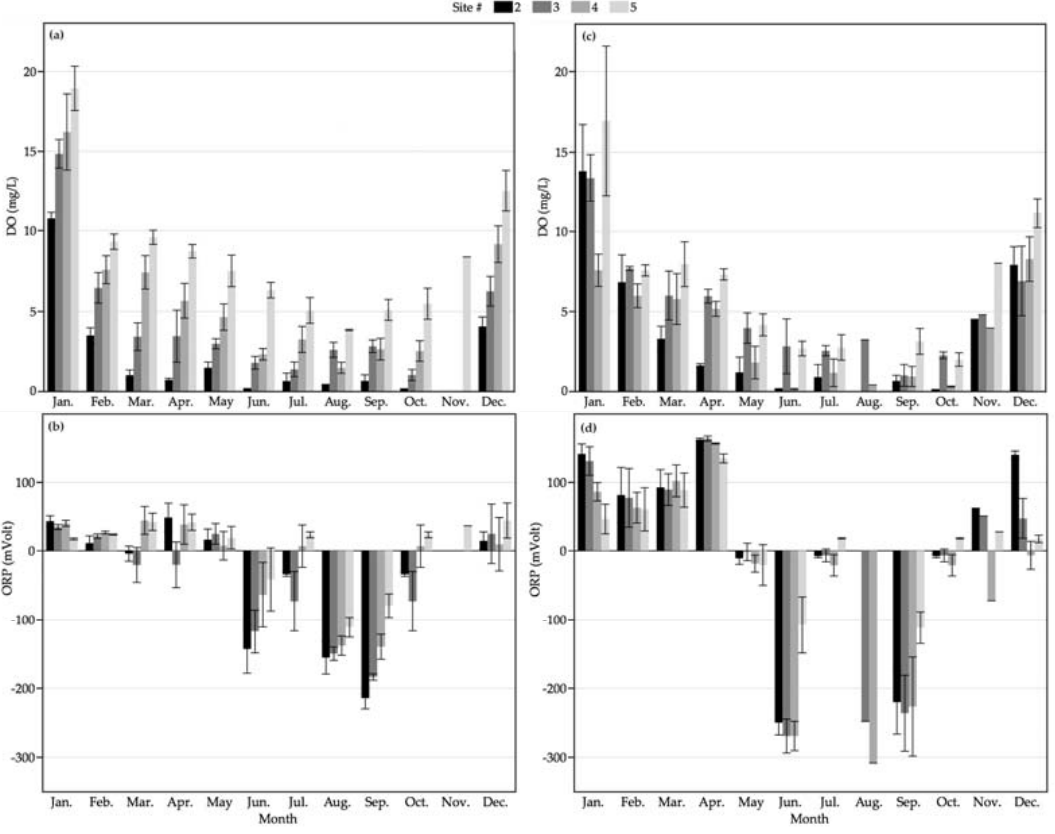
Figure 4. Monthly average dissolved oxygen (DO mg ∙ L − 1 ) and oxidation reduction potential (ORP, mVolt) measured within Sites 2 to 5 in: Constructed Wetland 1 (CW1) ( a,b ); and Constructed Wetland 2 (CW2) ( c , d ). Sites within CW1 include outflow from Stage 1 (Site 2), outflow from Stage 2 (Site 3), runoff ditch with effluent exiting Stage 2 (Site 4), and the stilling pond (Site 5). Sites within CW2 include outflow from Stage 1 (Site 2), outflow from Stage 2 (Site 3), outflow from Stage 3 (Site 4), and the stilling pond (Site 5). Error bars represent the standard error ( ± ) of the mean value.